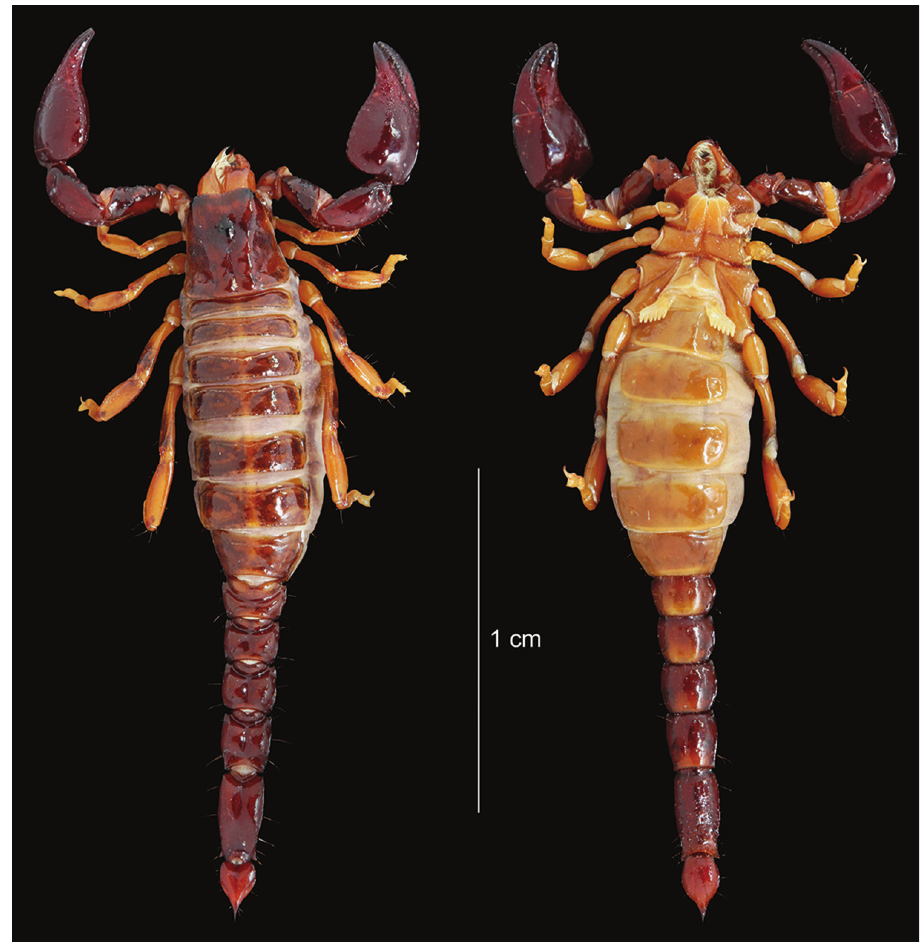
Figure 15. Auyantepuia aluku sp. n., female holotype from Apatou. Habitus, dorsal and ventral aspect.